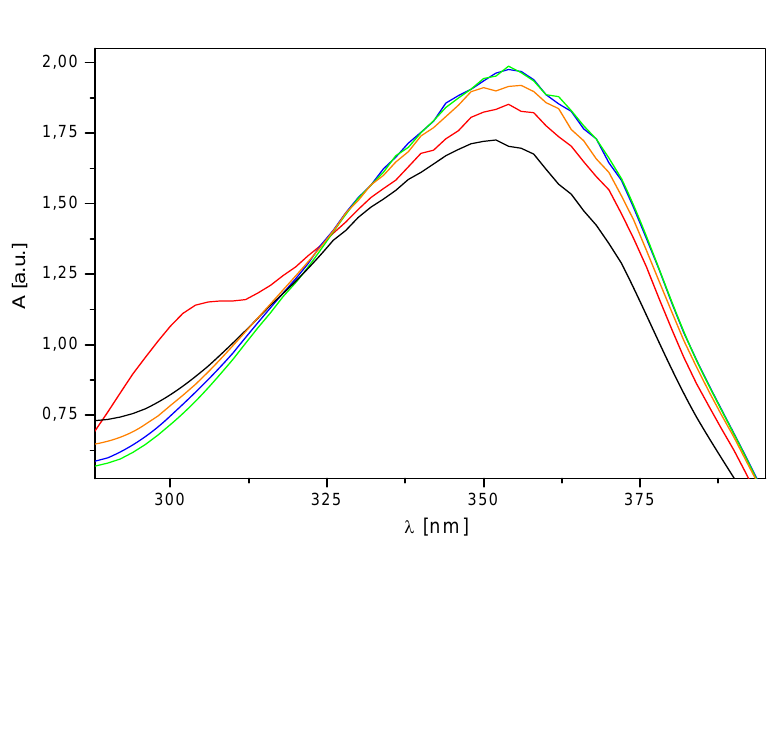
Figure 6. Absorption spectra of 4a in methanol (dissolution of 4a ( ⎯⎯ ), heating of solution to the boiling point of solvent ( ⎯⎯ ), irradiation with visible light (halogen lamp, t=30 s, ⎯⎯ ), irradiation with UV light (310 nm, t=15s, ⎯⎯ ), repeated heating of solution to the boiling point of solvent ( ⎯⎯ ), repeated irradiation with UV light (310 nm, t=15s, ⎯⎯